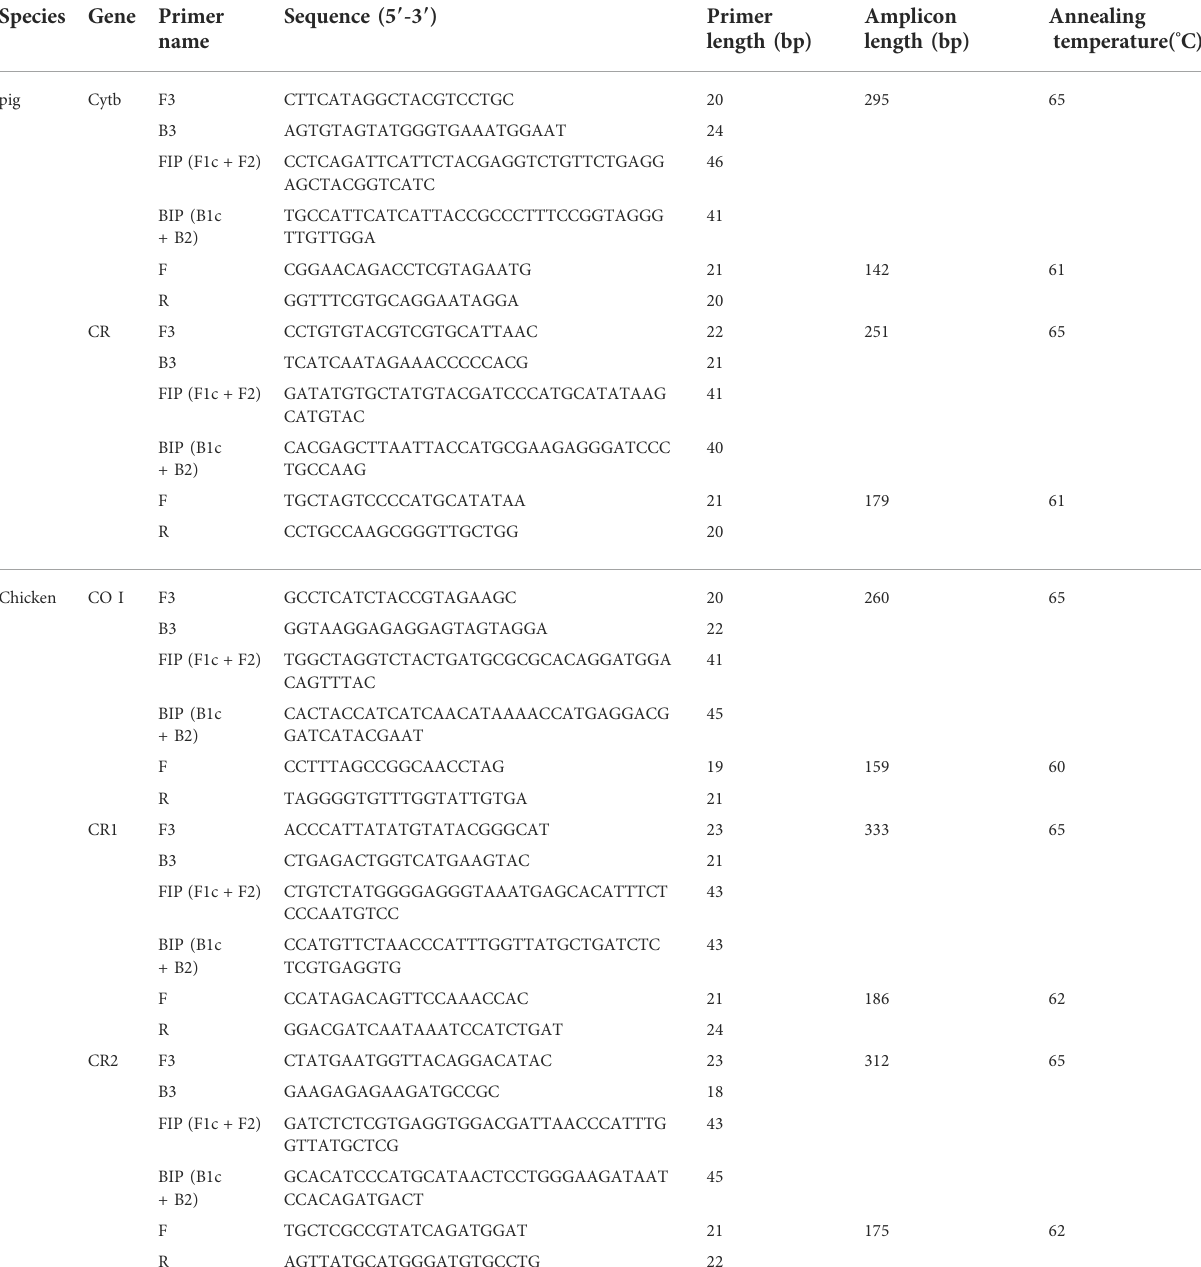
TABLE 2 Detail of PCR